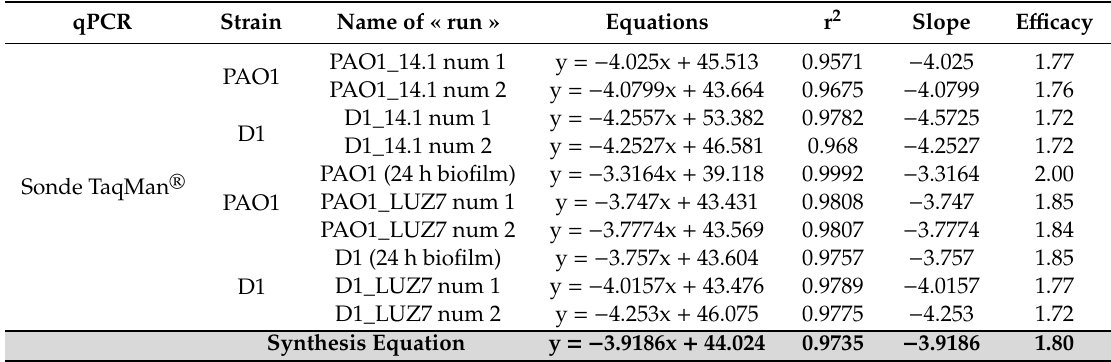
Figure A6. Sample PEMAX TM treatment procedure. Figure A 6. Sample PEMAX TM treatment procedure. Table A1. Synthesis of the qPCR TaqMan standard Table A 1. Synthesis of the qPCR TaqMan standard curve.